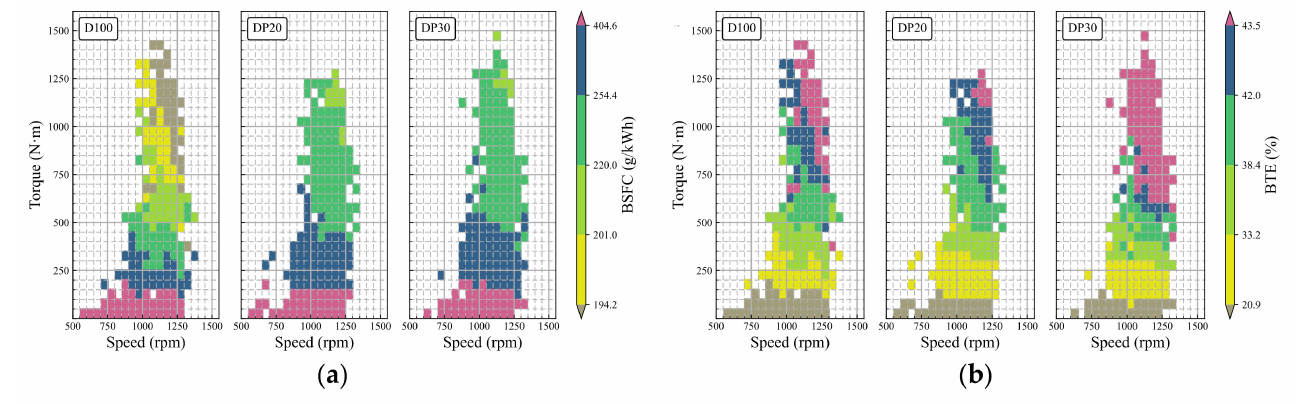
Figure 8. Transient engine maps of ( a ) BSFC and ( b )